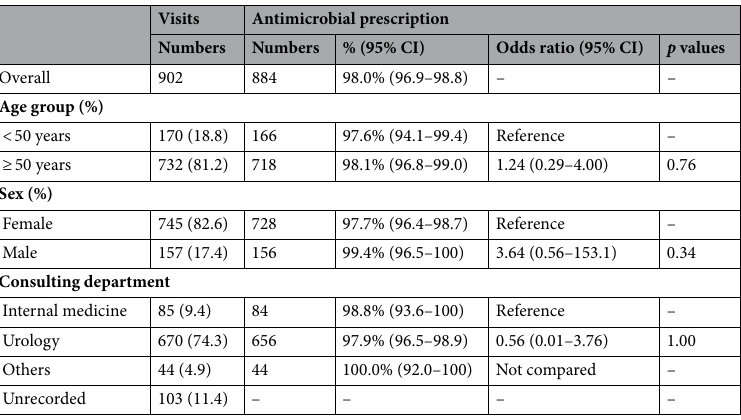
Table 3. Numbers and proportions of antimicrobial prescriptions for cystitis by age group, sex, and consulting department. CI confidence interval.